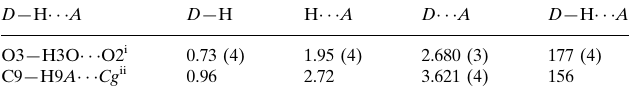
Hydrogen-bond geometry (A˚ , (cid:2) ). Cg is the centroid of the C2–C7